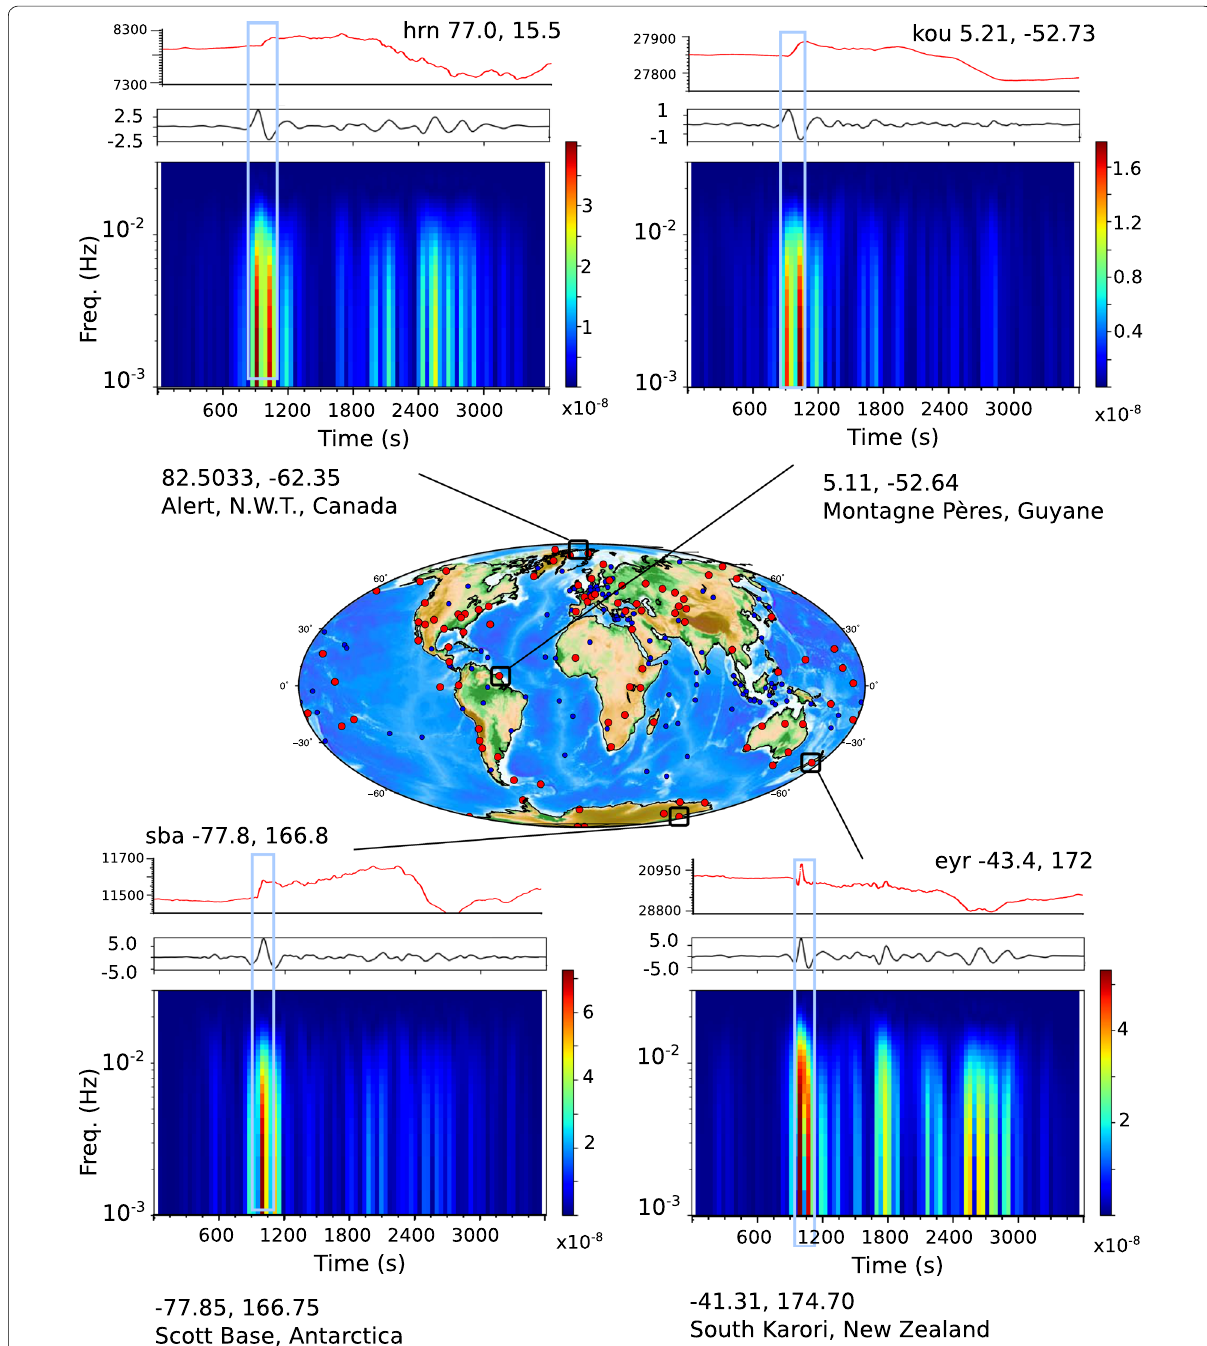
Fig. 2 Examples of 2017/09/07 SSC event recordings at seismic stations located at different latitudes. Data spans 1 h, starting 15 min before the onset of the SSC event. For each site, the upper panel shows in red the horizontal magnetic intensity (H) at the closest magnetic stations of the INTERMAGNET network. Middle panel shows the low-pass filtered (0.01 Hz) seismic acceleration and lowermost panel shows the spectrogram of 10 − the filtered seismic signal. Amplitude scale for the seismic signals is in m/s 2 ×